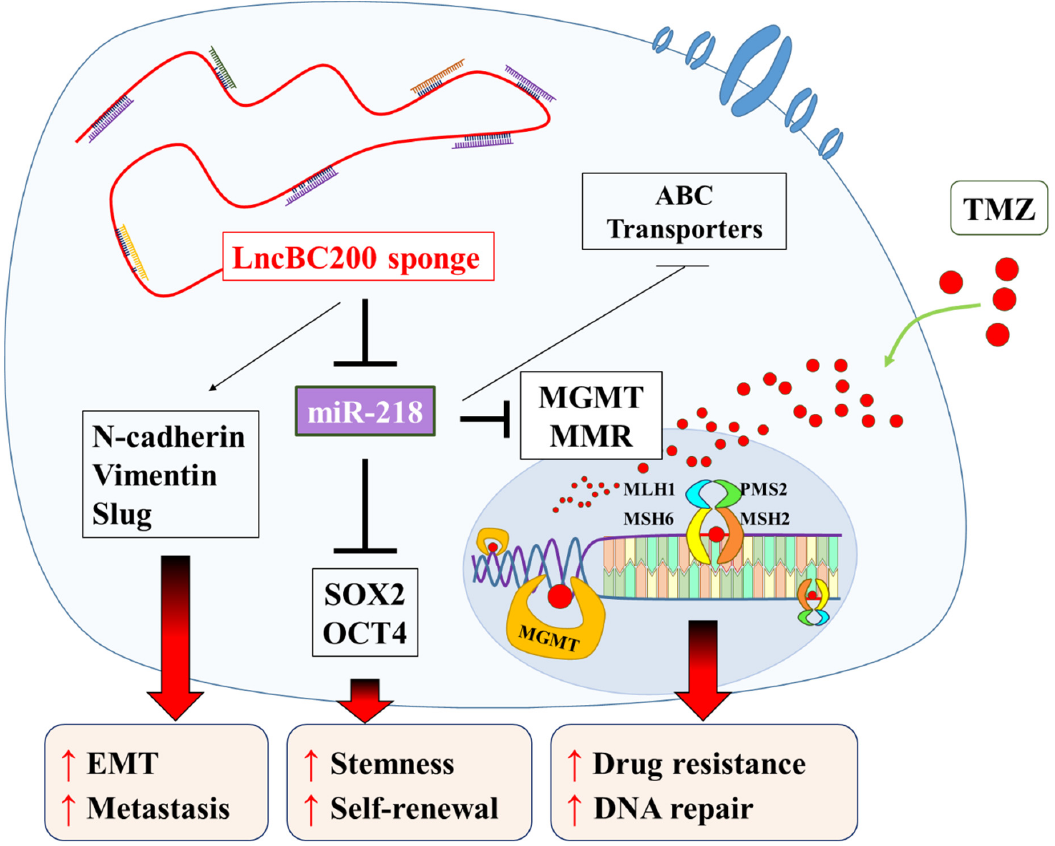
Figure 8. The lncRNA BC200 RNA sponges miR-218-5p regulated MGMT and MMR system enhancing self-renewal and TMZ resistance of GBM cells.